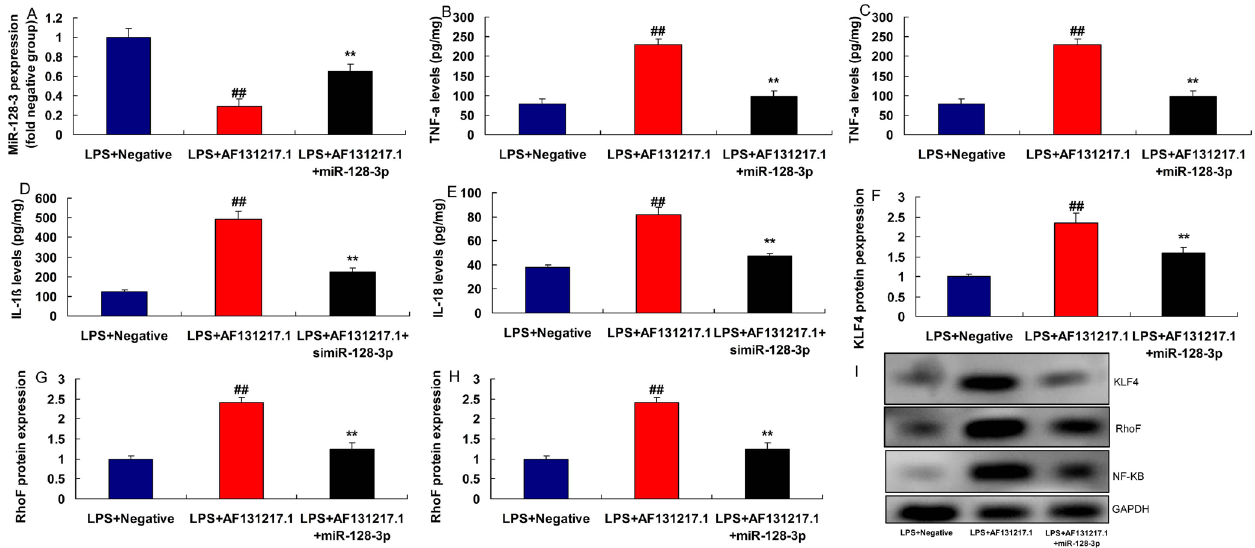
Fig. 7 - Long noncoding ribonucleic acid AF131217.1 regulated inflammation in the in vitro model via Kruppel-like factors (KLF) 4 by micro ribonucleic acid (miR)-128-3p. MiR-128-3p expression (A), tumor necrosis factor alpha (TNF-α), interleukin (IL)-6, IL-1β, IL-18, KLF4, RhoF, and nuclear factor kappa B (NF-κB) protein expressions (B, C, D, E, F, G, H, and I). LPS+Negative, LPS-induced in vitro model by negative mimics group; LPS+AF131217, LPS-induced in vitro model by AF131217.1 group; LPS+AF131217+miR-128-3p, LPS-induced in vitro model by AF131217.1 and miR-128-3p group. ## P<0.01 compared with LPS+Negative group; ** P<0.01 compared with LPS+ AF131217.1 group.